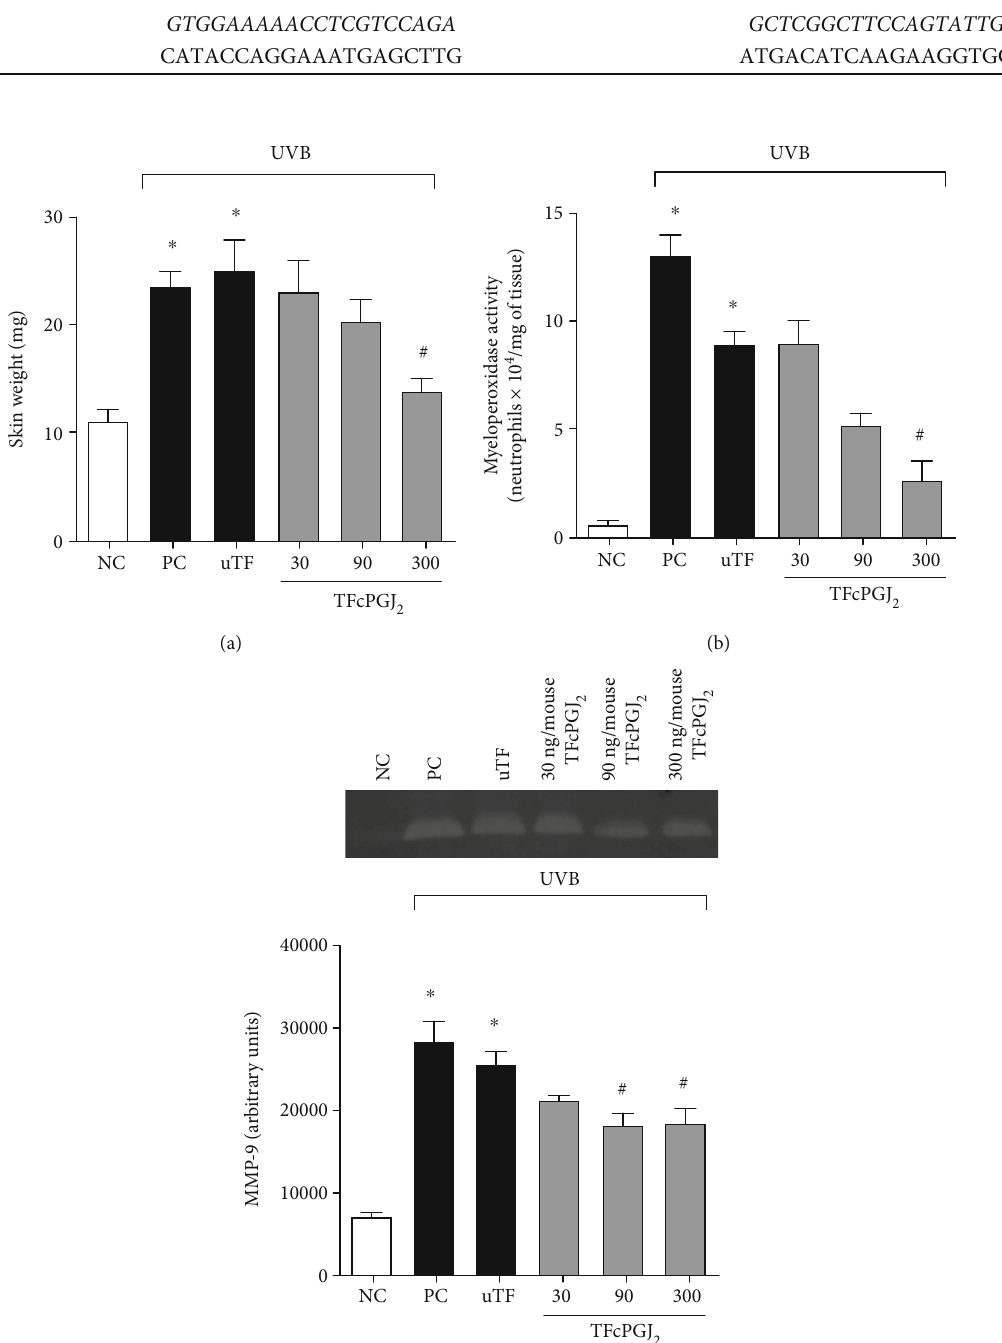
Figure 2: Topical formulation containing 15d-PGJ (TFcPGJ ) inhibits skin edema, myeloperoxidase activity, and MMP-9 activity triggered by 2 2 UVB. The skin edema (a), myeloperoxidase activity (b), and MMP-9 activity (c) were determined in samples collected 12h after the end of irradiation. Panel (c) presents data analysis of the activity of MMP-9 and a representative image. NC: negative control; PC: positive control; uTF: unloaded topical formulation. Bars are means ± SEM of 6 mice per group and are representative of two separate experiments. One-way ANOVA followed by Tukey ’ s test. ∗ p < 0 : 05 versus the negative control group; # p < 0 : 05 versus UVB-stimulated